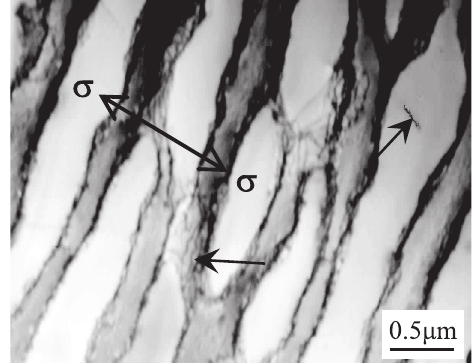
Fig. 4: Microstructure of the alloy crept for 40 h during steady state